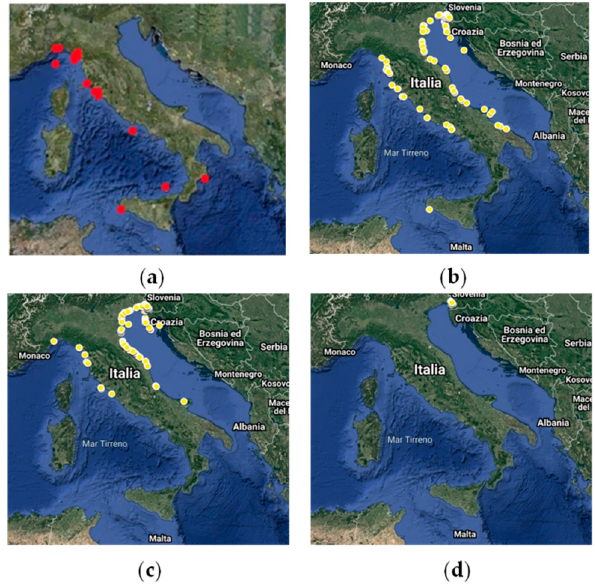
Figure 8. Maps of sighting locations of M. leidyi : ( a ) map with M. leidyi sightings modified after Boero et al. [20] received in summer 2009; ( b ) sightings sent through avvistAPP in 2019 (July–De-